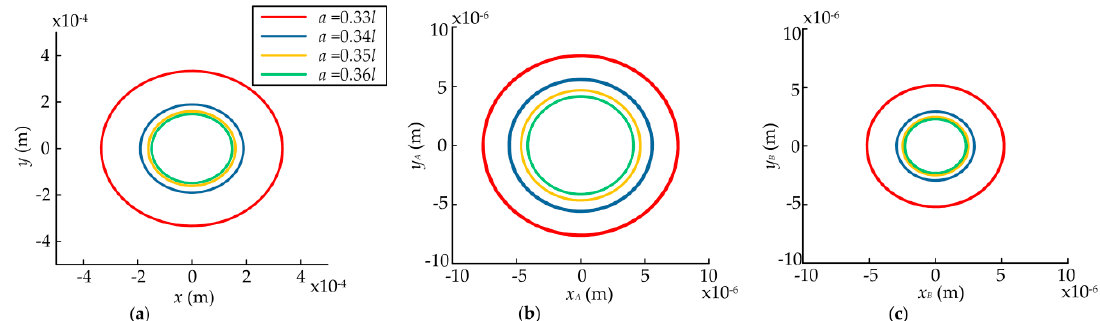
Figure 9. Rotor shaft orbits and bearing shaft orbits for different rotor offsets. ( a ) Rotor shaft orbits; ( b ) Left-bearing shaft orbits; ( c ) Right-bearing shaft orbits.